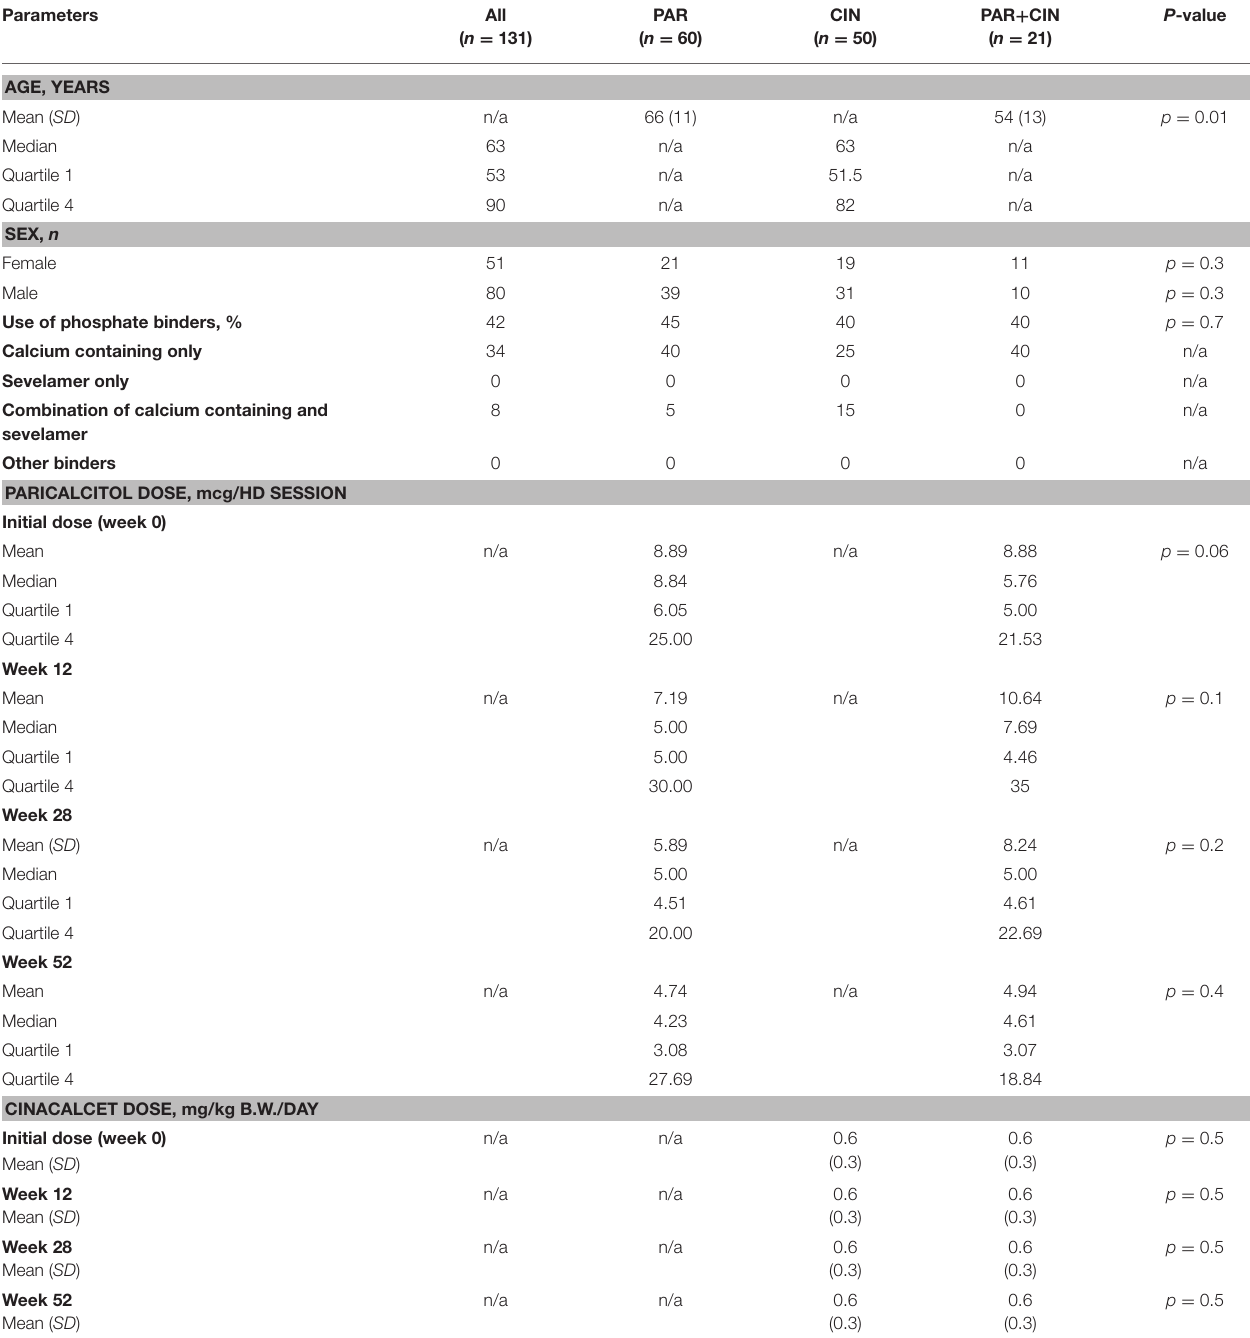
TABLE 1 | Clinical and demographic